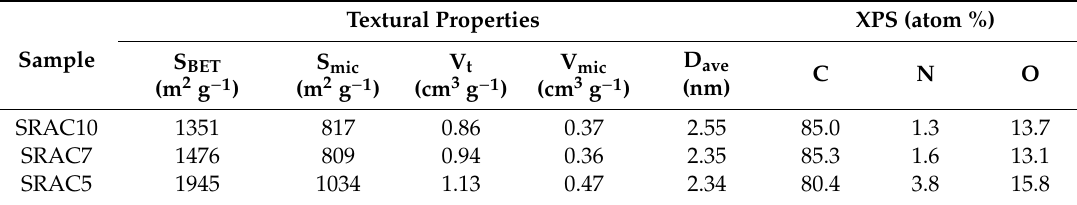
Table 1. Textural properties and element components of SRACs.